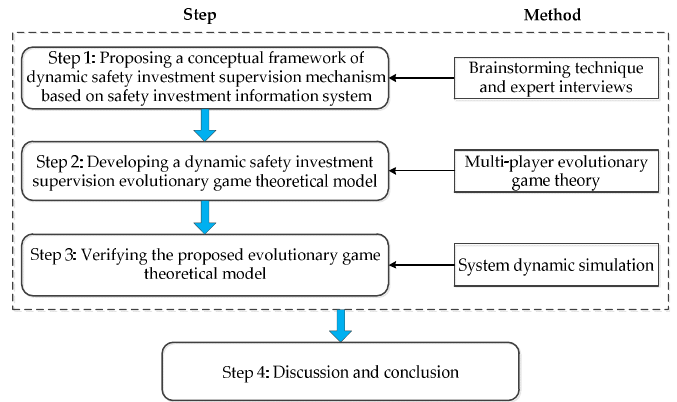
Figure 1. Flow of the overall research framework.